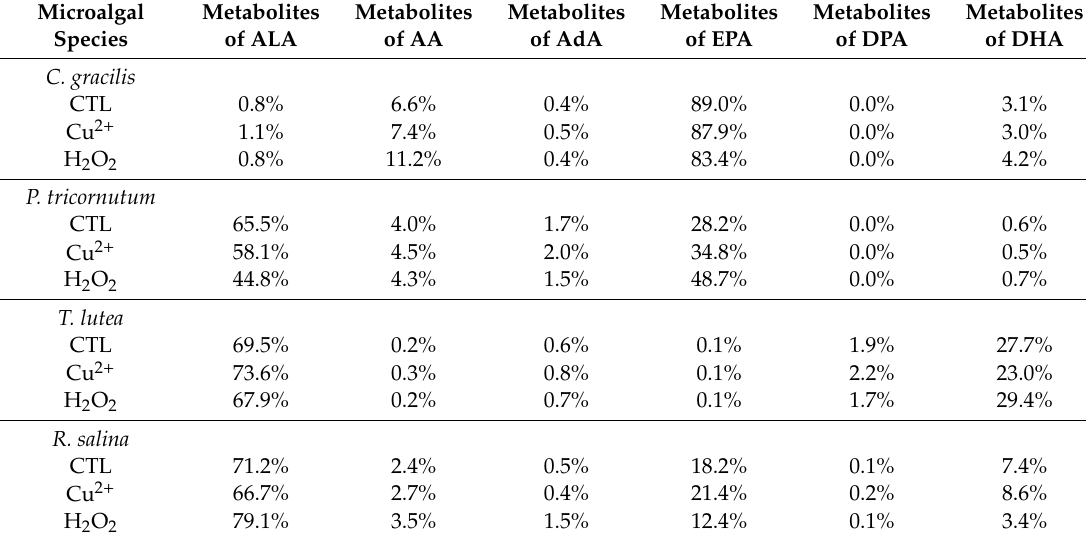
Table 1. Relative percentage distribution of each type of nonenzymatic oxidation-polyunsaturated fatty acids (NEO-PUFAs) in C. gracilis, P. tricornutum, T. lutea and R. salina : ALA ( α -linolenic acid), AA (arachidonic acid), AdA (adrenic acid), EPA (eicosapentaenoic acid), DPA n-6 (docosapentaenoic acid) and DHA (docosahexaenoic